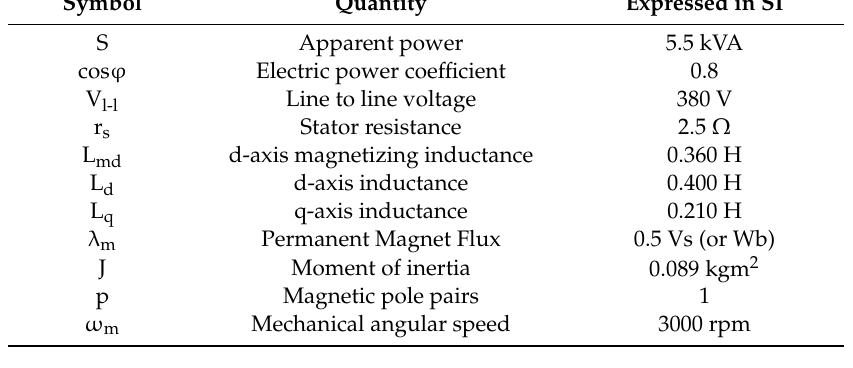
Figure 5. The observer and power supply blocks in more details as they used in simulation for PMSM sensorless control.